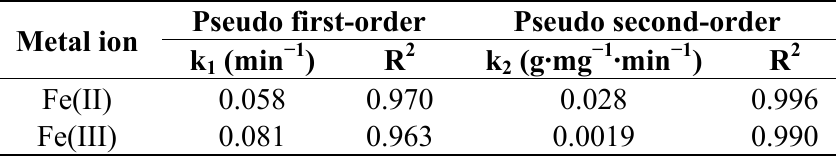
Table 1. Kinetic parameters for Fe(II) and Fe(III) adsorption on TCCTS